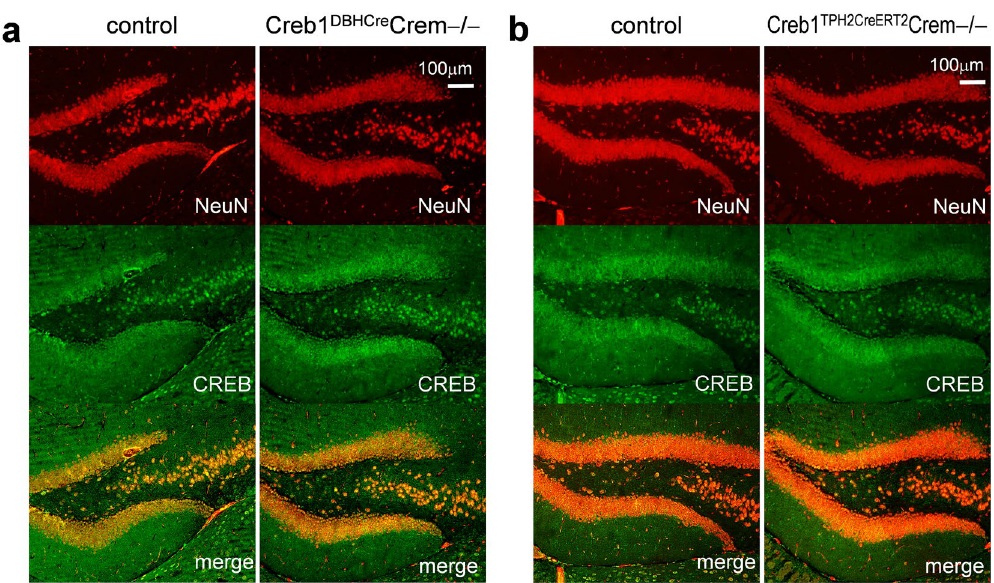
Figure 2. Immunofluorescent staining of hippocampal sections confirms promotor dependent selectivity of CREB deletion. CREB expressing cells are still present in the hippocampus – a brain structure not targeted by the mutation; ( a ) CREB (green) and NeuN (red) staining in the hippocampus of control and Creb1 DBHCre / Crem − / − mutant mouse, ( b ) CREB (green) and NeuN (red) staining in the hippocampus of control and Creb1 TPH2CreERT2 /Crem − / − mutant